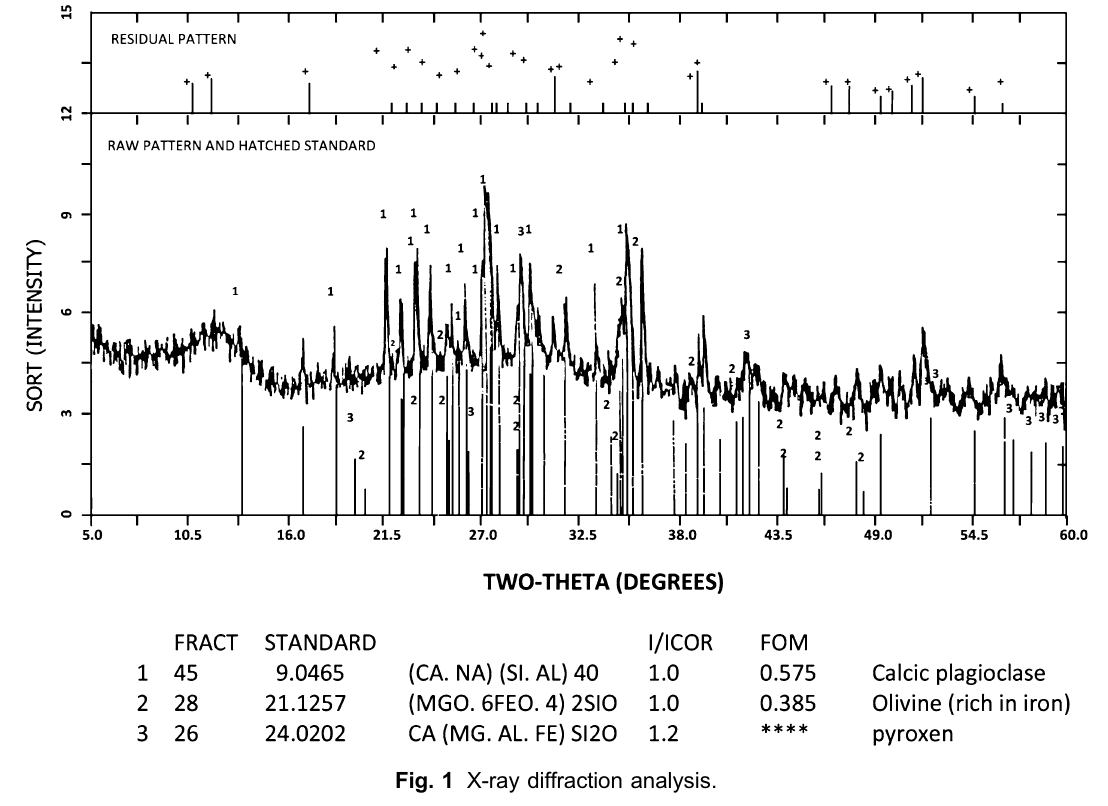
Fig. 1 X-ray diffraction analysis.